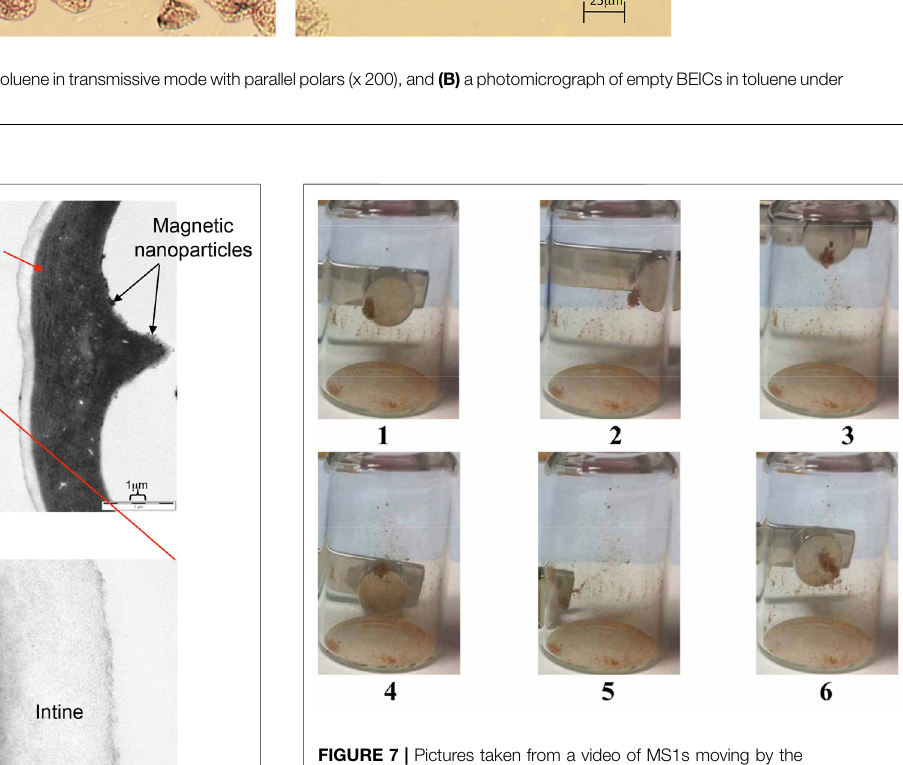
FIGURE 7 | Pictures taken from a video of MS1s moving by the application of a magnet fi